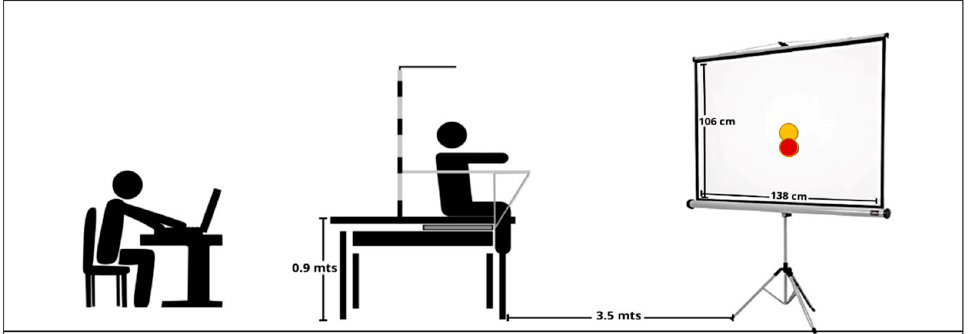
Figure 1. Settings for trunk control test throughout posturography on stable surfaces (red point = target point; yellow dot = CoP displacement).